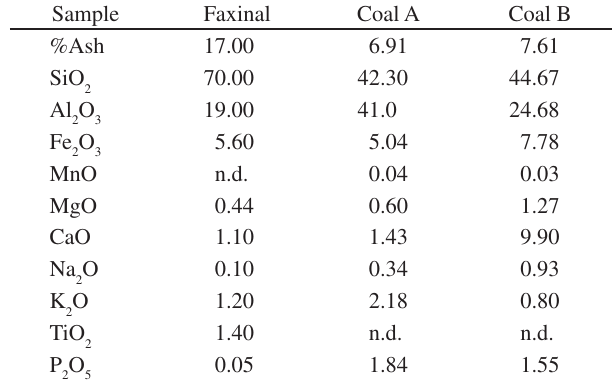
Table 3. Ash chemical composition of Faxinal, A and B coals.